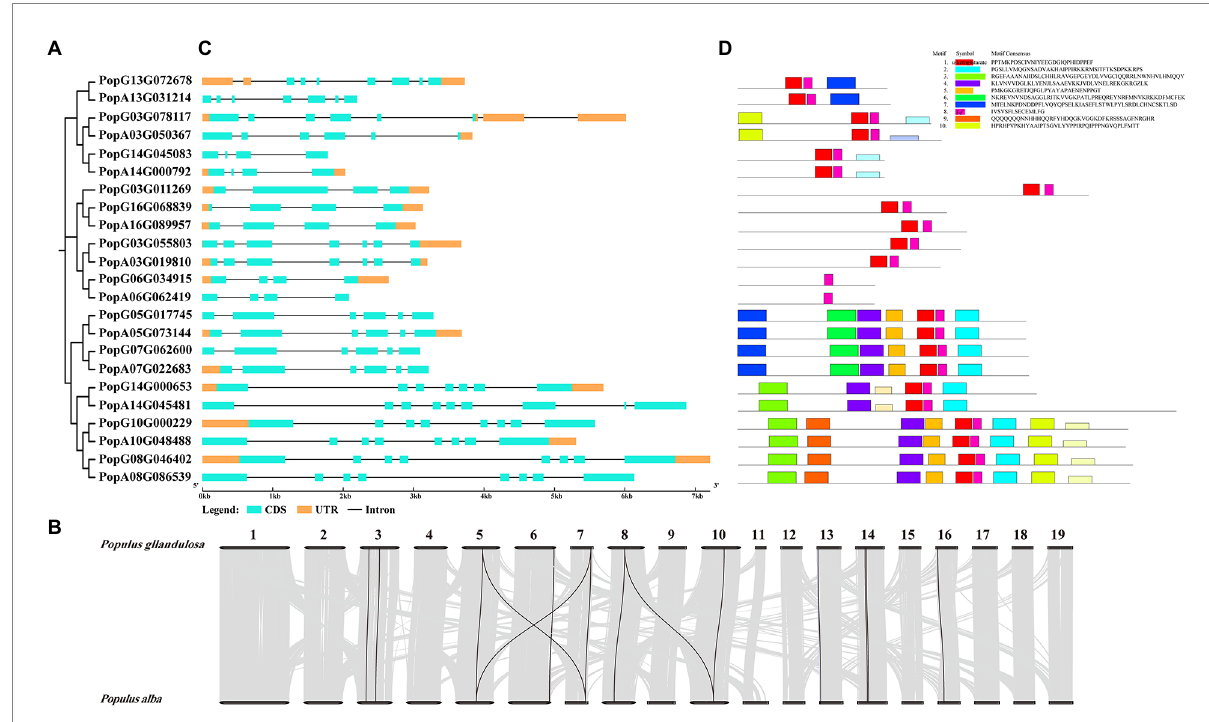
FIGURE 1 (A) Phylogeny of PagALKBH proteins identified in poplar 84K. (B) Genome distribution and collinearity of the PagALKBH family in poplar 84K. Black lines indicate the collinear relationships of PagALKBHs , gray lines represent other than PagALKBHs collinear relationships. (C) Gene structures of PagALKBHs . The exons, untranslated regions (UTR), and introns were represented by amber and cyan rectangles, and the blank line, respectively. (D) Conserved motifs of PagALKBHs . Different motifs are represented by different